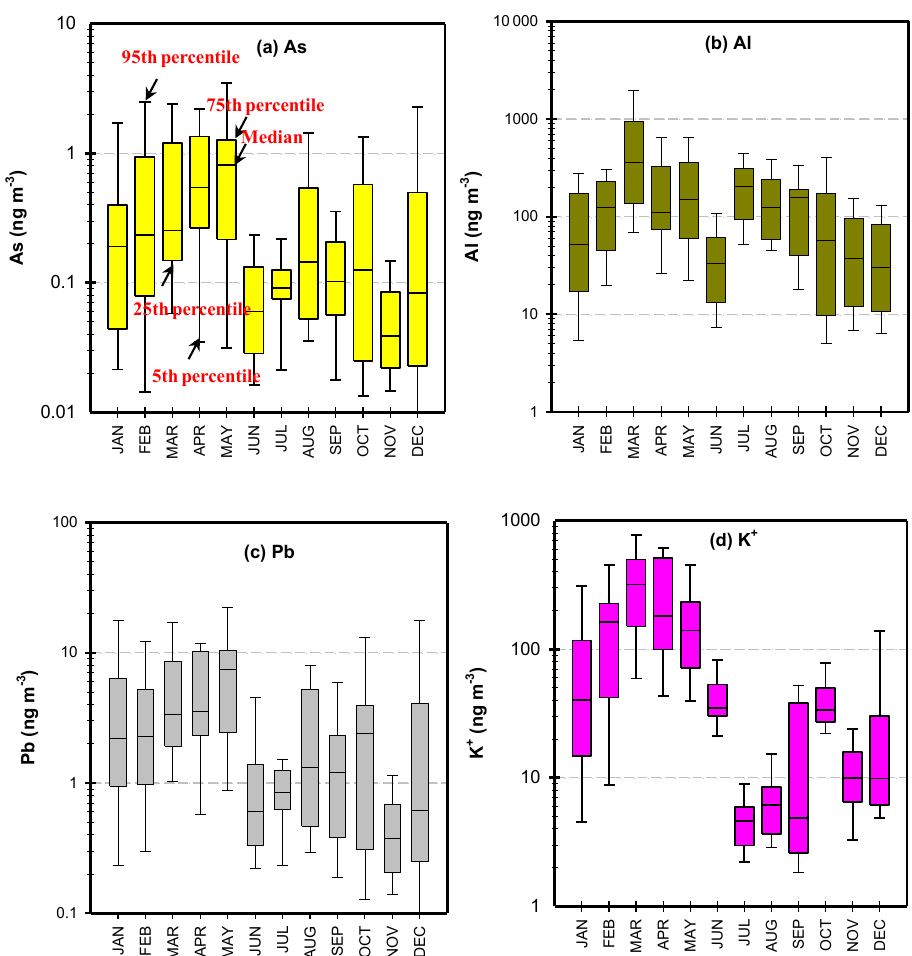
Figure 4. Monthly distributions of 95th, 75th, 50th, 25th, and 5th percentile values of (a) As, (b) Al, (c) Pb, and (d) K + concentrations observed at Mount Hehuan from 2011 September to 2012